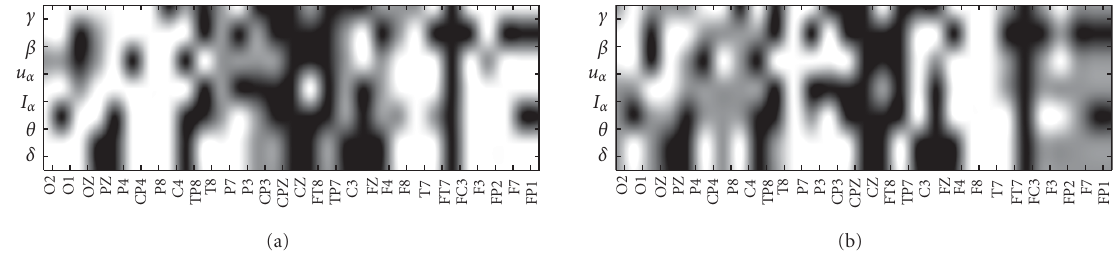
Figure 6: Features selected in a “good” subset of the original spectral features and their overlap between two subjects. (a) Subject 6, (b) subject 1. White indicates the feature was not selected, grey indicates that the feature was selected for that subject only, and black indicates the feature was selected for both